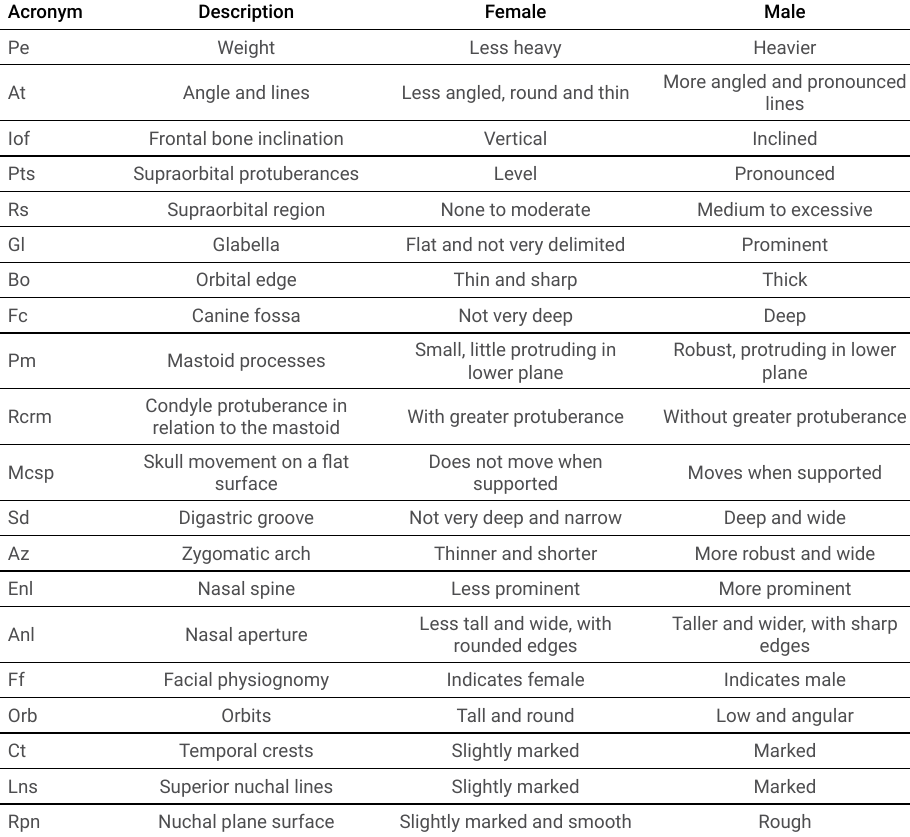
Table 1. Morphological characteristics of skulls according to